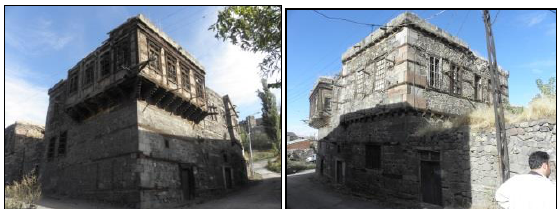
Figure 2. The Selamlık (on the left) and haremlik (on the right) sections of the